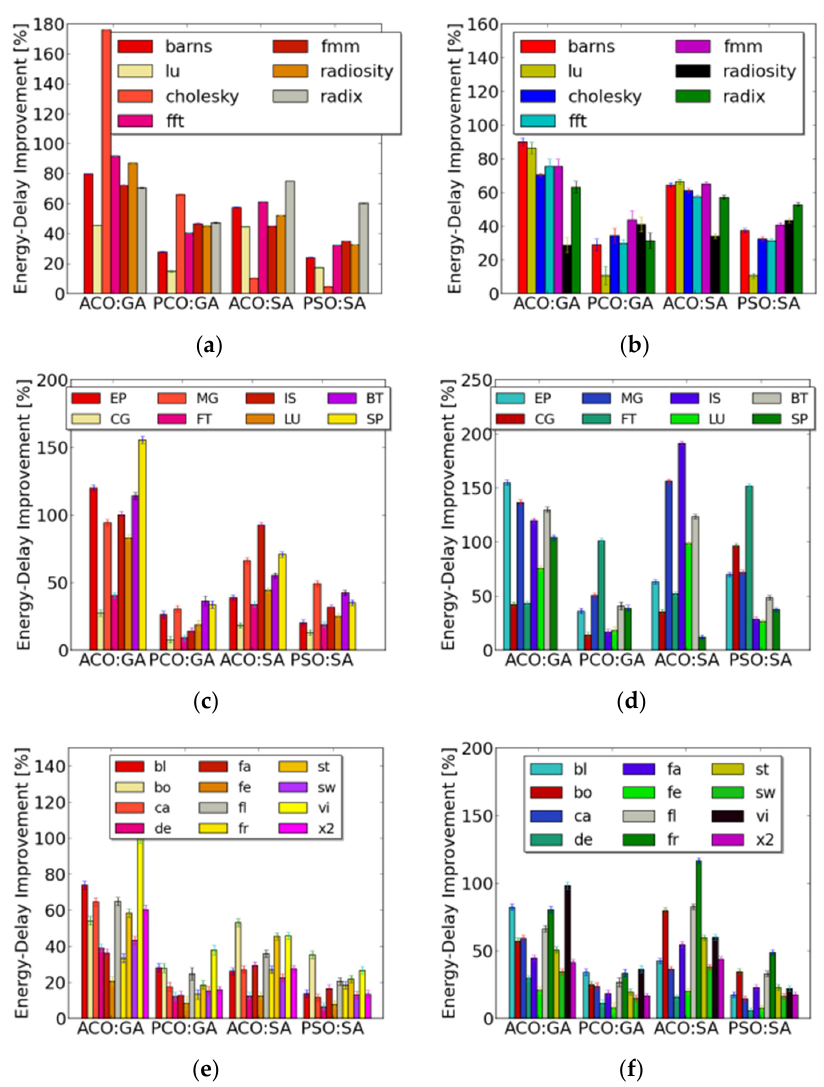
Figure 14. EDP improvements for solutions generated by ACO and PSO over SA and GA for ( a ) 6 × 6 SPLASH-2; ( b ) 10 × 10 SPLASH-2; ( c ) 6 × 6 NAS; ( d ) 10 × 10 NAS; ( e ) 6 × 6 PARSEC; ( f ) 10 × 10 PARSEC benchmarks.